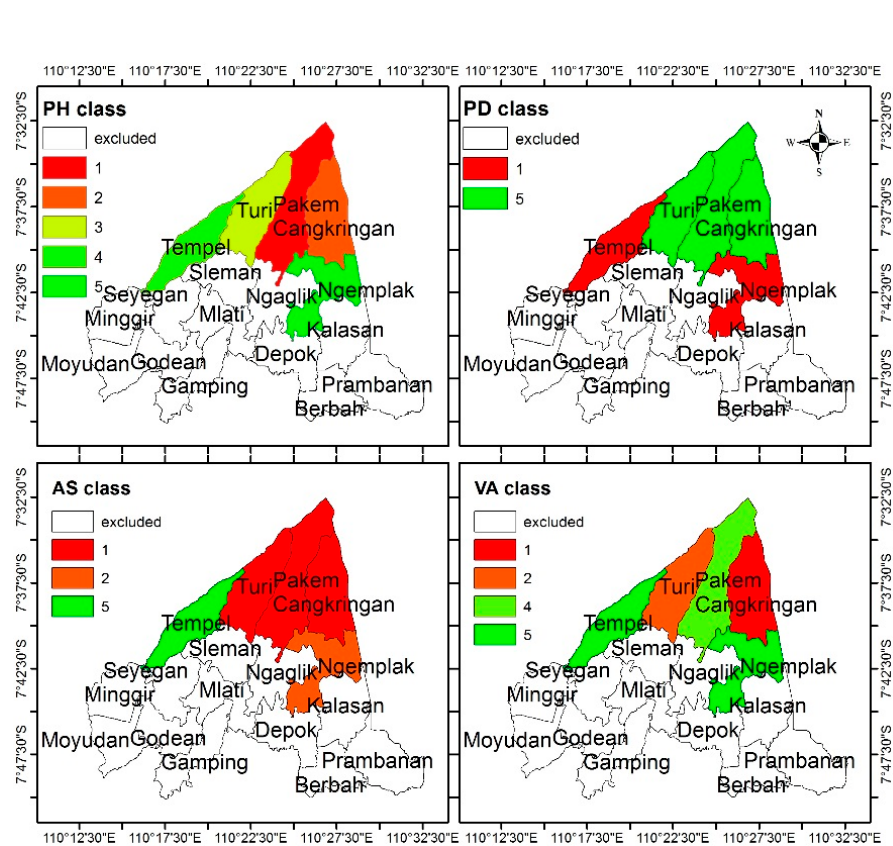
Figure 3. Spatial data for the zone ranking from 1 (most prioritised) to 5 (least prioritised). PH = proximity to hazard, PD = population density, AS = accessibility to shelter, VA = percentage of vulnerable age.